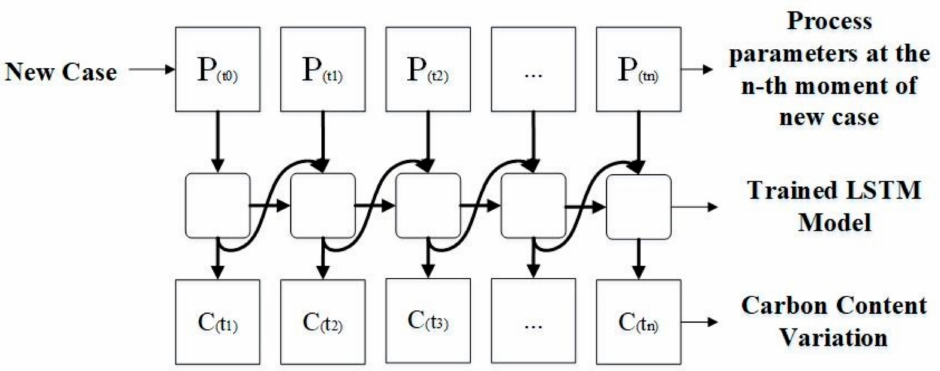
Figure 9. Process of model validation. Where P(tn): process parameters (oxygen flow, lance position, bottom blowing gas flow and carbon content) at the n-th moment. C(tn): carbon content at the n-th moment.